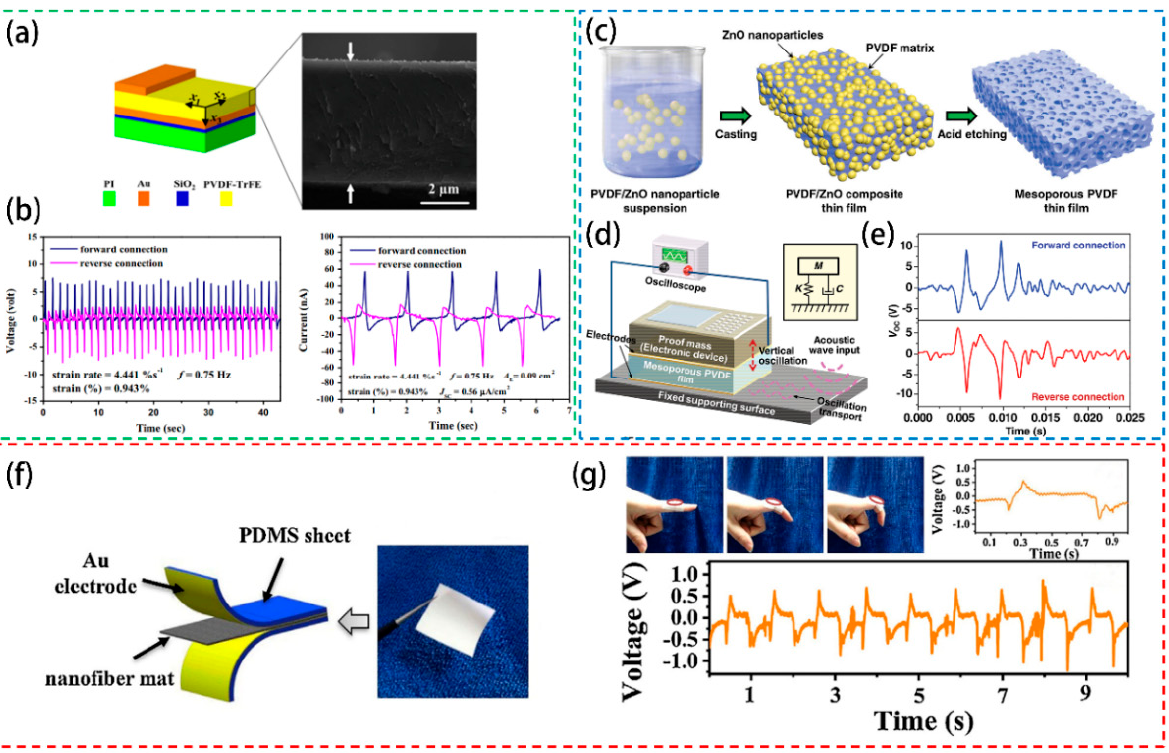
Figure 5. ( a ) Schematic illustration of P(VDF-TrFE) thin film-based NG and cross-sectional SEM image of the 6.5 µm thick copolymer film. ( b ) The open-circuit voltage and short-circuit current of a piezoelectric thin film-based NG subject to loading frequency f = 0.75 Hz and strain magnitude 0.943%. Reproduced from [9] with permission from the Elsevier, copyright 2014. ( c ) Schematic procedure for fabricating mesoporous piezoelectric PVDF thin films. ( d ) Schematic setup for characterizing PVDF thin film NGs for harvesting mechanical energy from surface oscillations. The mesoporous PVDF thin film-weight system can be simplified as a free vibration system with damping, as shown in the inset. ( e ) The voltage output of a PVDF thin film NG (fabricated from a 50% ZnO mass fraction mixture) generated during one cycle of surface oscillation. The blue and red curves were collected under forward and reverse connections. Reproduced from [26] with permission from the John Wiley and Sons, copyright 2014. ( f ) The schematic illustration of BZT-BCT/P(VDF-TrFE) nanogenerator and the photo of the nanofiber mats. ( g ) The output voltage from the generator with 40 wt% BZT-BCT content attached on the finger joint. Reproduced from [135] with permission from the Elsevier, copyright 2021.